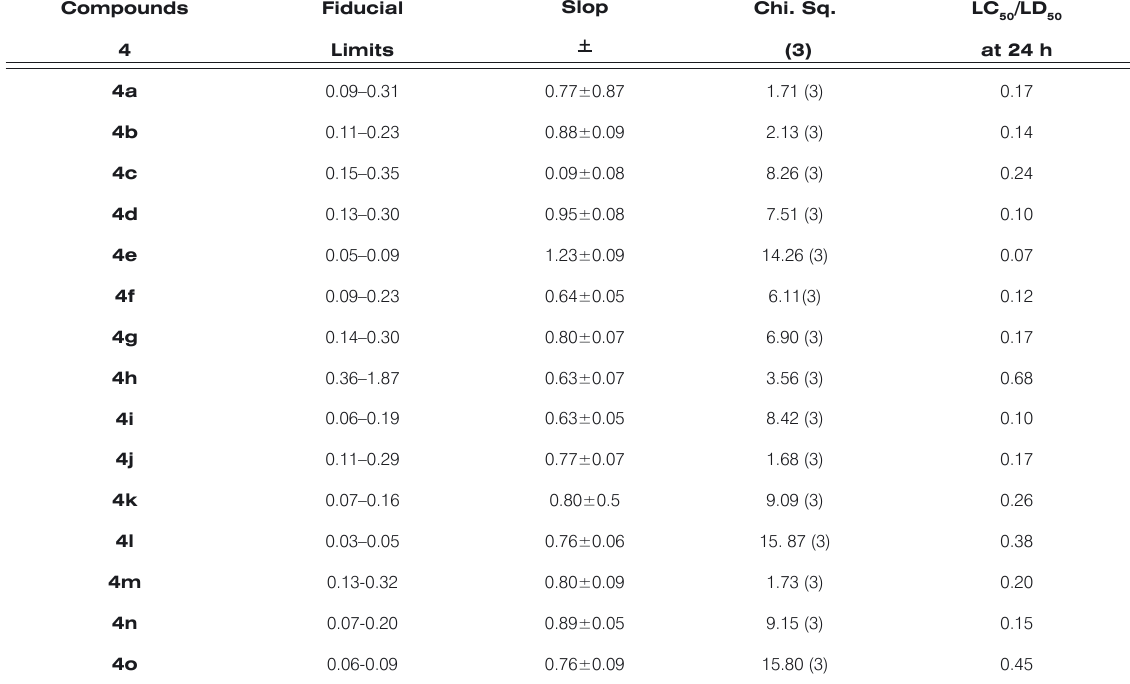
Table 5. Acaricidal activity of compounds 4a - 4o